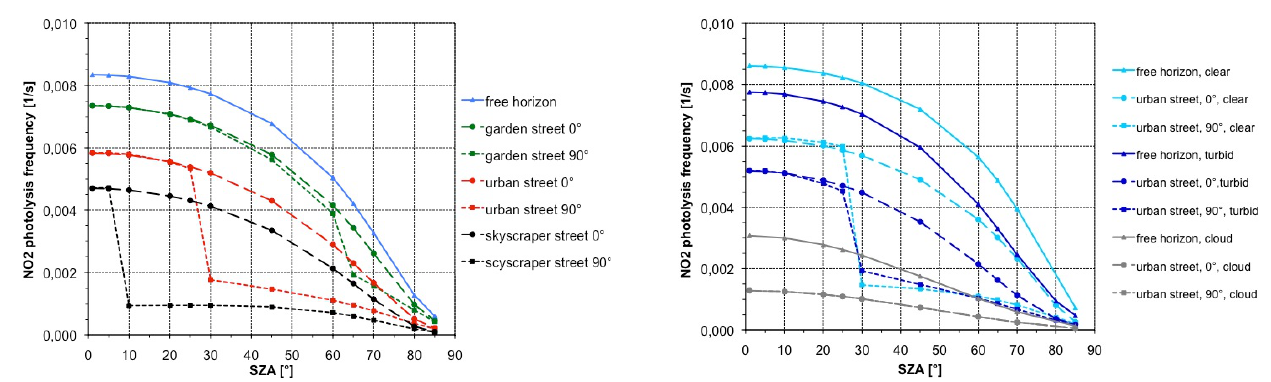
Fig. 4. J NO as function of the solar zenith angle for a cloud-free 2 atmosphere with average turbidity for undisturbed conditions with free horizon and for three street types with street orientation parallel ( ϕ =0 ◦ ) and perpendicular to the sun ( ϕ =90 ◦ ).